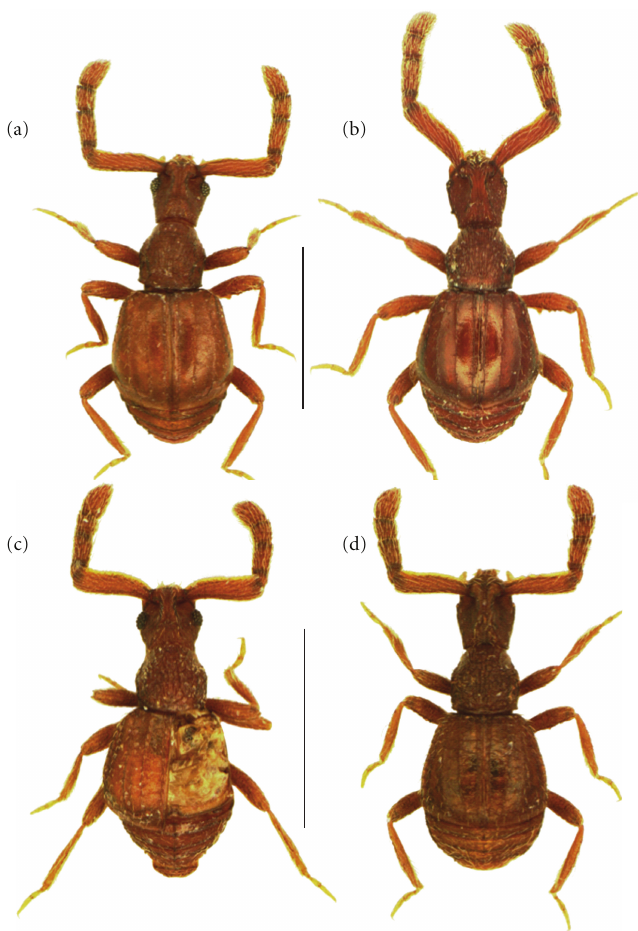
Figure 1: (a) and (b) Paragoniastes ra ff rayi , male, macrophthalmus (a) and microphthalmus (b). (c) and (d): P. besucheti , male, macroph- thalmus ((c): holotype of P. parki ) and microphthalmus ((d): holotype). Scale bars: 1mm.